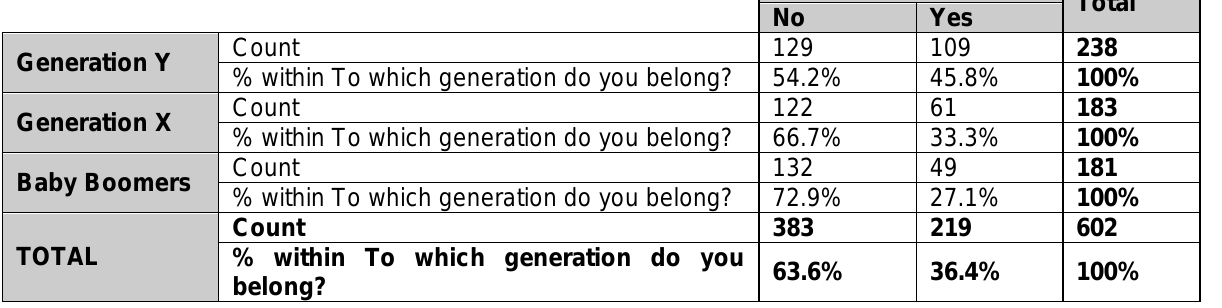
Done volunteer work